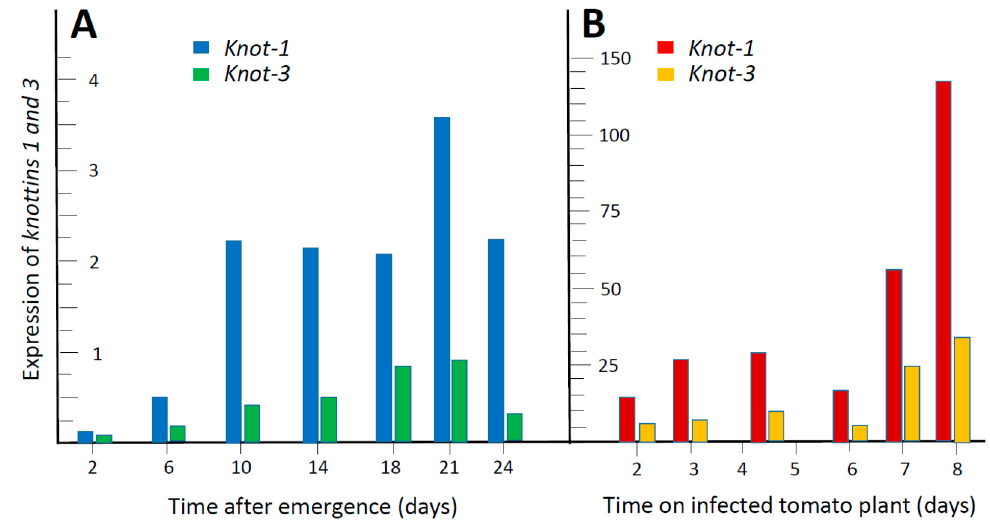
Figure 2. Expression of knot-1 and knot-3 during adult whitefly development and upregulation by Tomato yellow leaf curl virus (TYLCV). ( A ) qPCR quantification of transcripts (relative to β - actin ) in synchronized whitefly populations reared on tomato plants, collected at the time indicated after emergence; ( B ) Five- to seven-day-old whiteflies were caged with leaves of TYLCV-infected tomatoes and the amounts of transcripts were estimated by qPCR (relative to β - actin ) at the time indicated thereafter. Pools of about 50 insects were used for each time point.